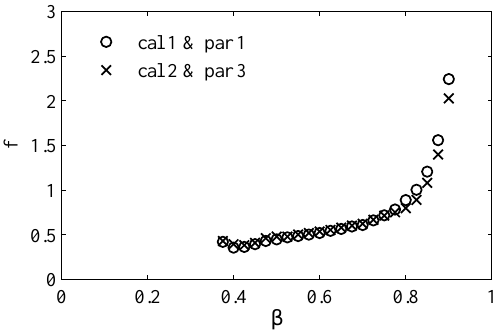
Fig. 7. Cross-river profiles of z 0 for boat-mounted ADCP parameter and calibration surveys.